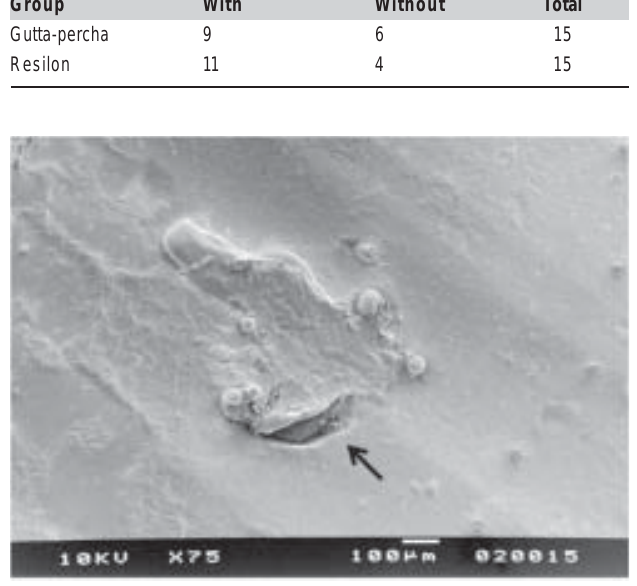
Figure 2. Group 2 (Resilon TM ). SEM micrograph of a tooth subjected to apicoectomy after root canal filling with Resilon TM cones. Arrow indicates to gap areas (×75